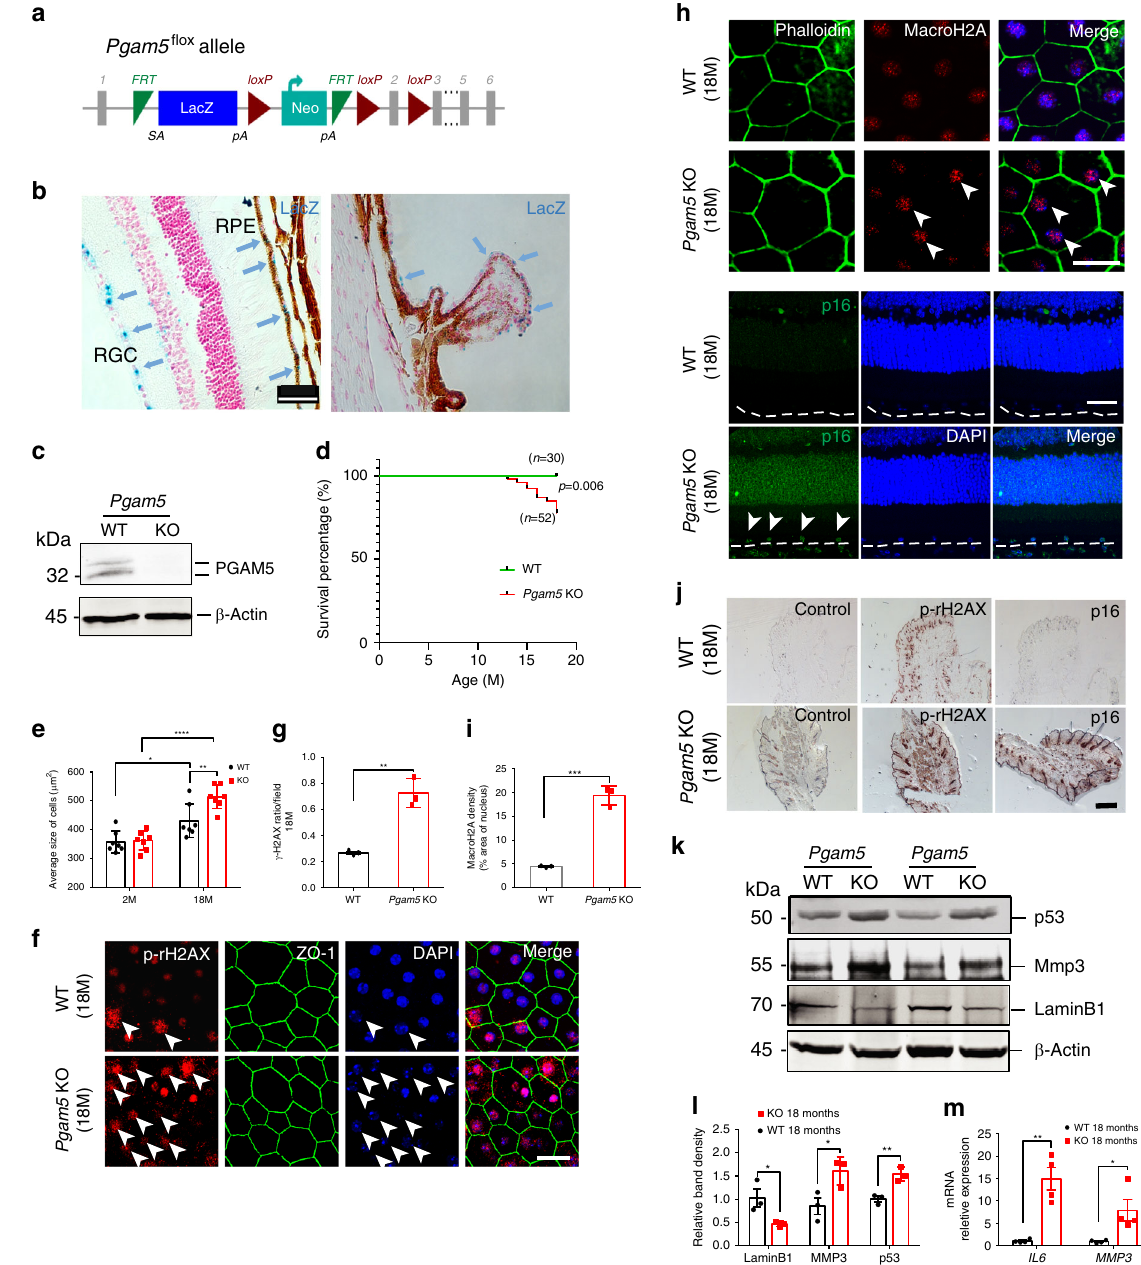
Fig. 1 Cellular senescence induced by PGAM5 deletion in vivo. a Schematic of the Pgam5 fl ox allele with LacZ location noted. Exon 2 is fl anked by loxP; b β -gal (lacZ) activity detected in Pgam5 − / − mice. High LacZ activities were shown in RPE, RGC and ciliary body epithelium. Scale bar: 100 µ m. c Western blot con fi rming PGAM5 deletion in vivo ( β -Actin as loading control). n = 3. d Kaplan – Meier survival analysis of Pgam5 − / − mice. Animal numbers were shown, p = 0.006, Log-rank (Mantel – Cox) test. e RPE cell size from WT and Pgam5 − / − mice at 2 and 18 months. n = 7. * p = 0.0263, ** p < 0.005, **** p < 0.0001, two-way ANOVA, Tukey ’ s multiple comparisons test. Error bars, mean ± s.d. f Flatmount phopho- γ H2AX staining in the RPE layer of WT and Pgam5 − / − mice at 18 months n = 3. Scale bar: 20 µ m. Arrows point to the nucleus with karyorrhexis. g Statistics of phospho- γ H2AX ratio/each fi eld in WT and Pgam5 − / − mice at 18 months. n = 3. ** p = 0.0022, two-tailed unpaired t -tests. Error bars, mean ± s.d. h MacroH2A, Phalloidin and P16 Ink4a immunostaining in WT and Pgam5 − / − Retina/RPE sections at 18-months-old. Scale bar: 20 µ m (macroH2A) or 50 µ m (p16). n = 3. i Quanti fi ed macroH2A density in WT and Pgam5 − / − RPE cells. n = 3. *** p = 0.0002, two-tailed unpaired t -tests. Error bars, mean ± s.d. j Immunohistochemistry of phospho- γ H2AX and P16 Ink4a in WT and Pgam5 − / − mice skin at 18-months-old. In control group, no primary antibodies were used. Scale bar: 500 µ m. n = 3. k Western blots of p53, Lamin B1 and MMP3 from RPE/choroid sample in WT and Pgam5 − / − mice ( β -Actin as loading control). n = 3; l Quanti fi cation of p53, Lamin B1 and MMP3 bands relative to β -Actin in k . n = 3, * p = 0.0244 for Lamin B1, p = 0.04 for MMP3, ** p = 0.0077 for p53, two-tailed unpaired t -tests. Error bars, mean ± s.d. m Il-6 and Mmp3 mRNA level in the RPE/choroid of WT and Pgam5 − / − mice at 18 months. n = 4, ** p = 0.0016, * p = 0.0276, two-tailed unpaired t -tests. Error bars, mean ± s.e.m. For assays in the fi gure, n represents the number of biologically independent experiments. Images were captured under same settings, and representative images were shown. Source data are available as a Source Data fi